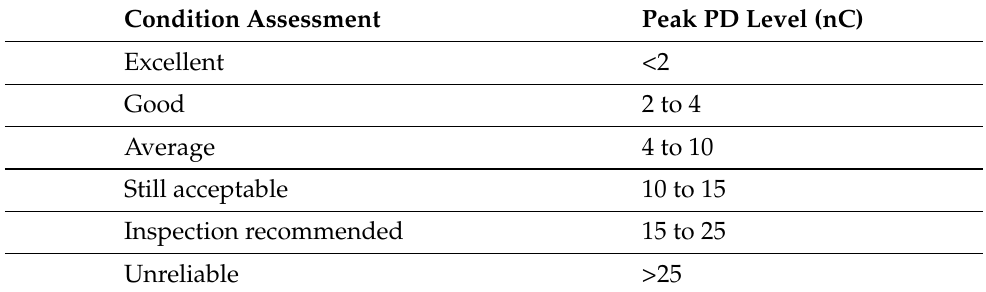
Table 1. PD levels